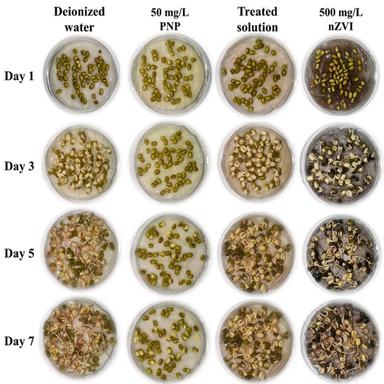
Germination of mung bean seeds in different solutions.